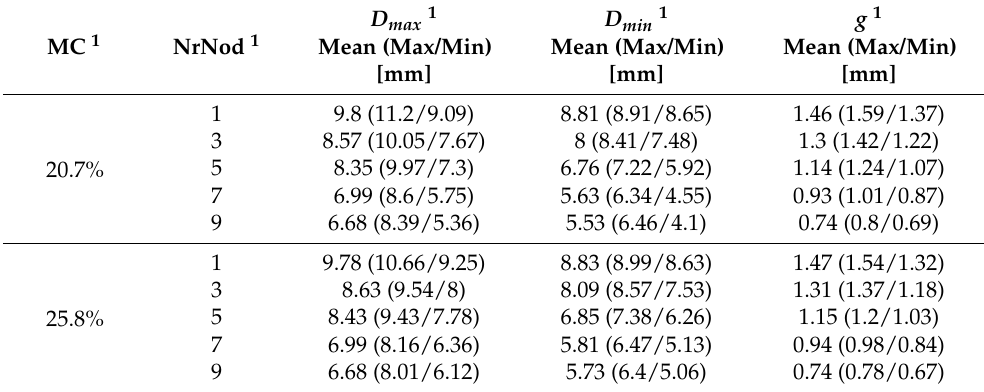
Table 2. Dimensions of the miscanthus stalk samples’ cross-section used for compression tests along the grain.